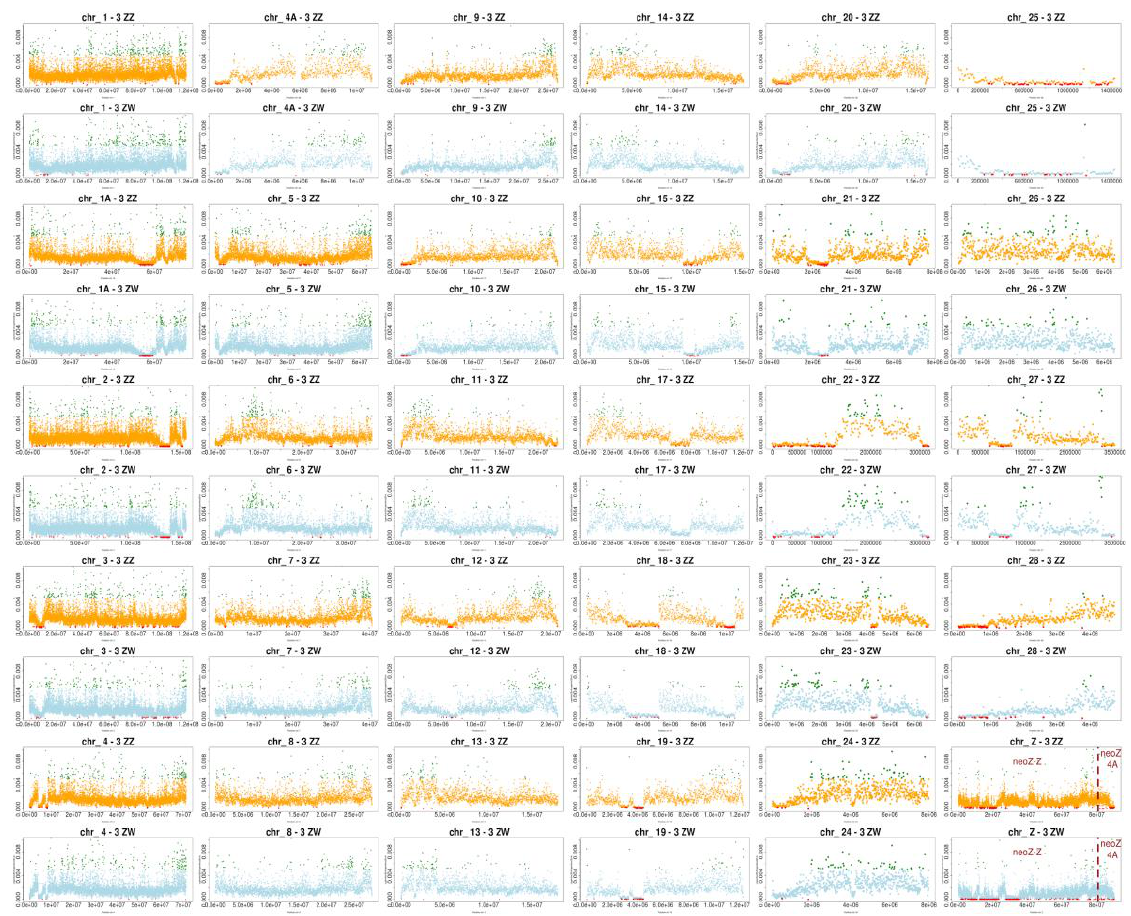
Figure S5 . Nucleotide diversity variations along 30 Z. borbonicus chromosomes as estimated using genetic informatio n from three males (πmales, orange) and three females (πfemales, light blue). For each dataset, top 2.5% and bottom 2.5% of π values among windows scanning all chromosomes are shown in green and red, respectively. The chromosomal breakpoint on the neoZ chromosome is shown with a red